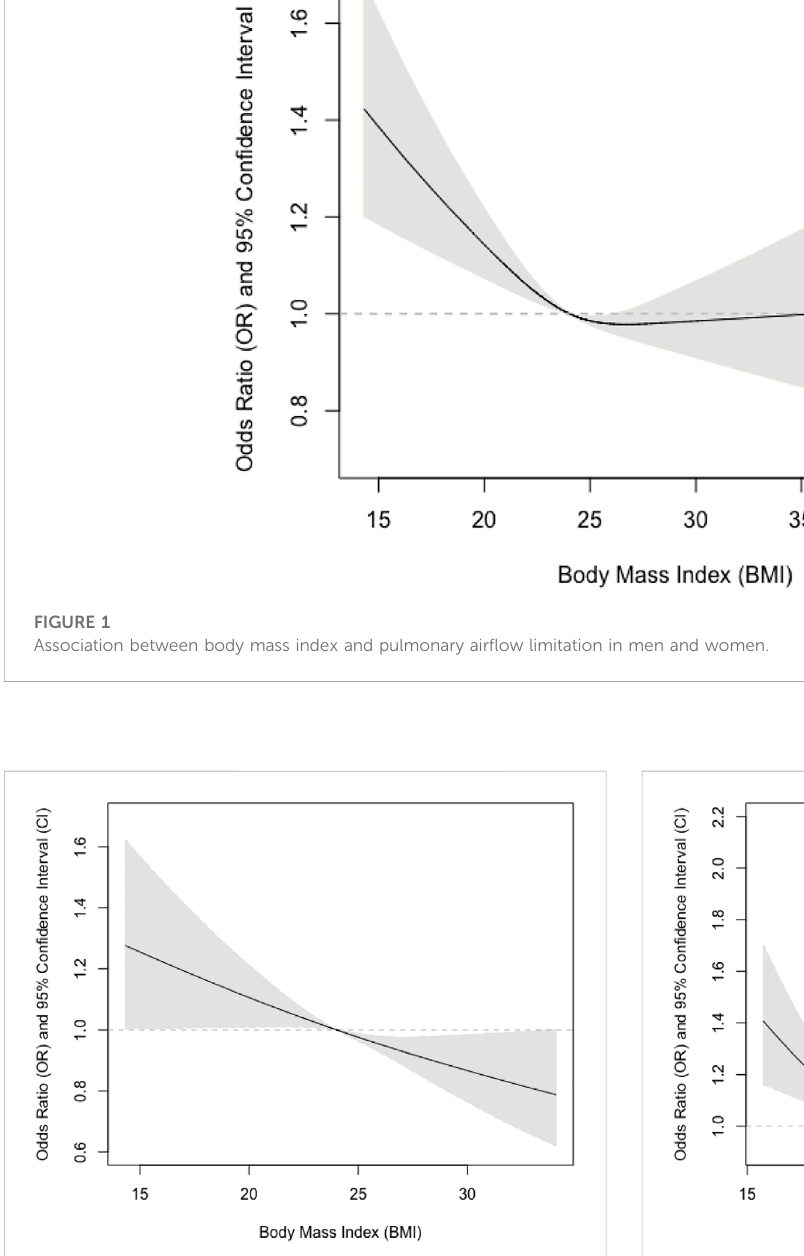
FIGURE 3 Association between body mass index and pulmonary air fl ow limitation in